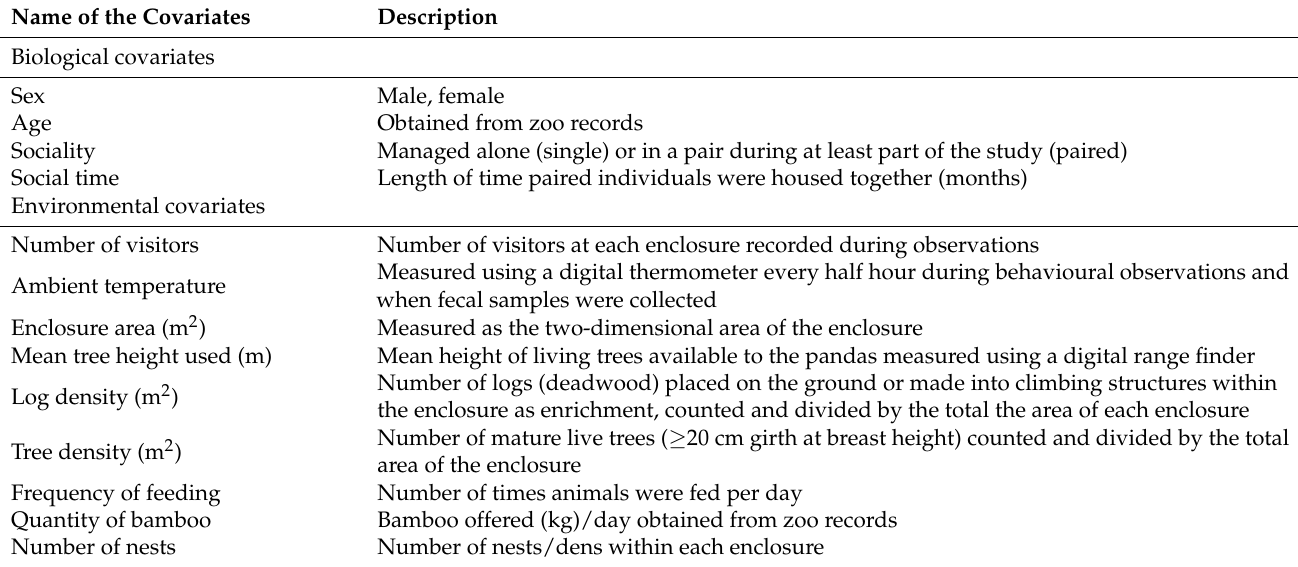
Table 1. Details of biological and environmental covariates collected during the